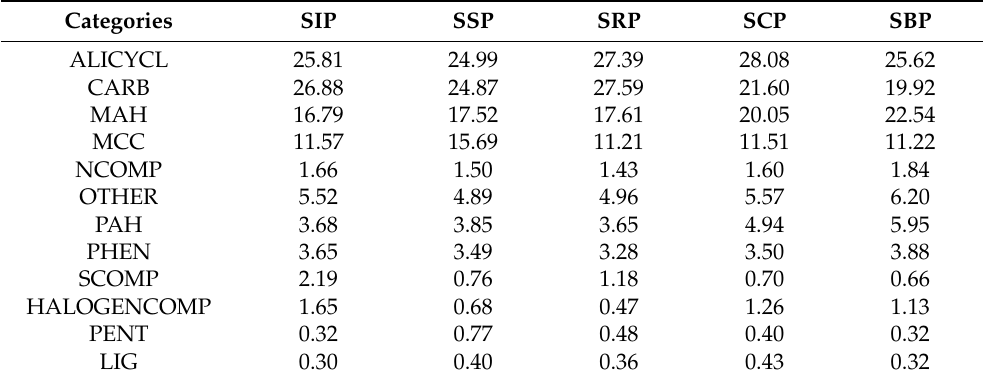
Table 4. Pyrolysis product groups and relative proportions (%) of the DOM samples